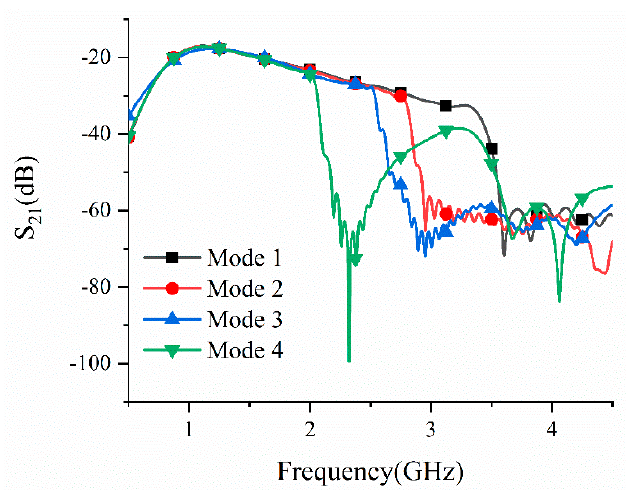
Figure 12. Measured S 21 magnitude of the proposed antenna.